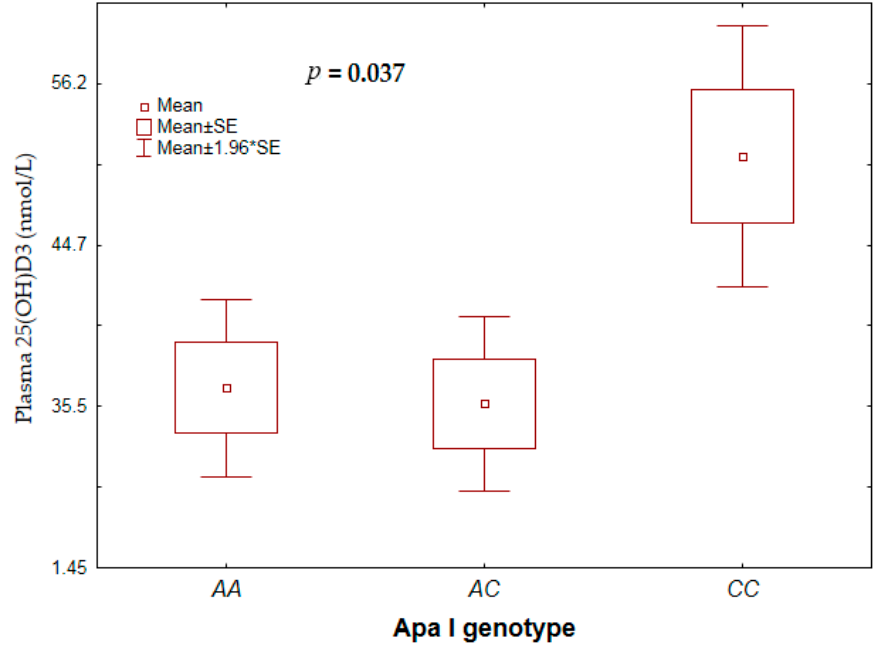
Figure 3. Association between vitamin D deficiency status and rs7975232 ( Apa I) genotype.